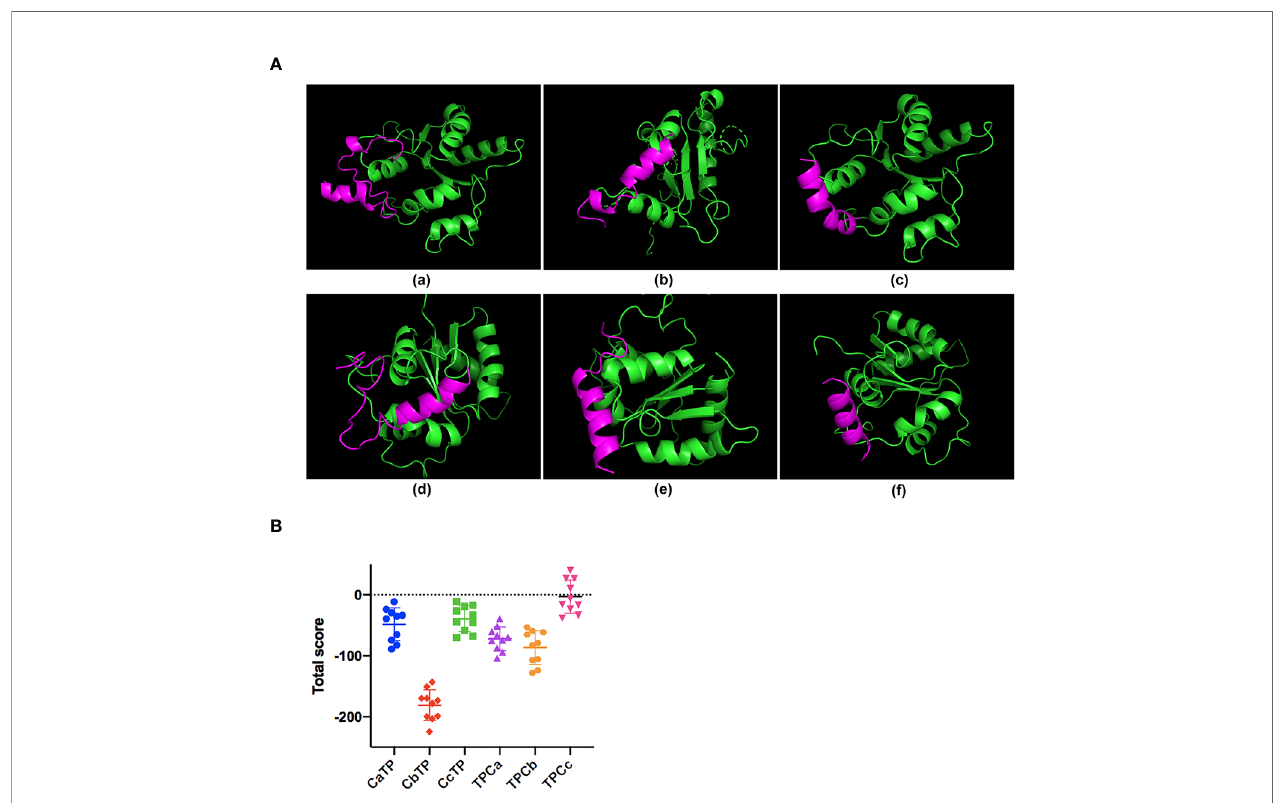
FIGURE 1 | The binding ability of the hybrid peptides to TLR2. (A) The overall structure of the peptide-TLR2 complex. (A-a) TLR2-CaTP; (A-b) TLR2-CbTP; (A-c) TLR2-CcTP; (A-d) TLR2-TPCa; (A-e) TLR2-TPCb; (A-f) TLR2-TPCc. The green ribbons represent TLR2, and the red ribbons represent the hybrid peptide. (B) Energy plot of 10 of 100 decoy structures from the hybrid peptide-TLR2 docking study by fl expepdock. The data are shown as the mean ± standard